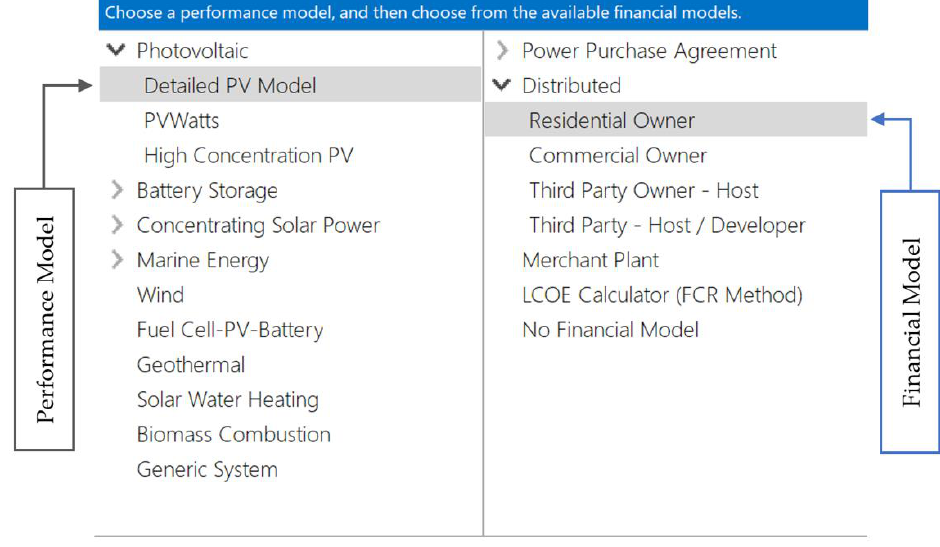
Figure 13. Performance and financial model selected for the study. Source: [18].